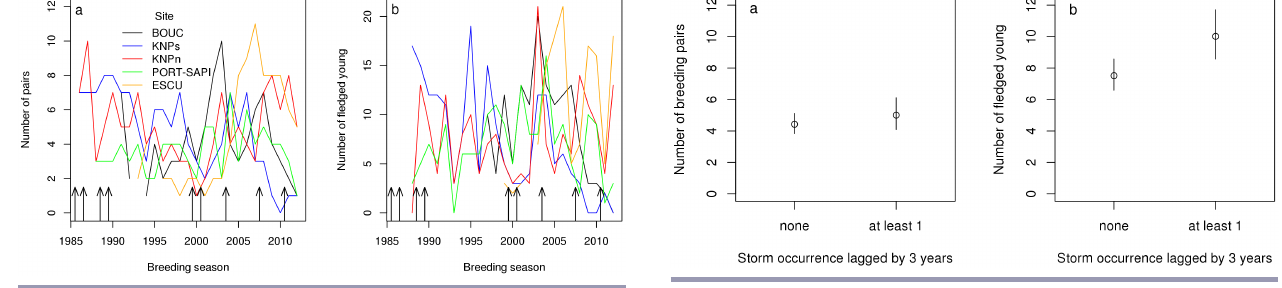
occurrence lagged by 3 years (model-averaged effect size on log